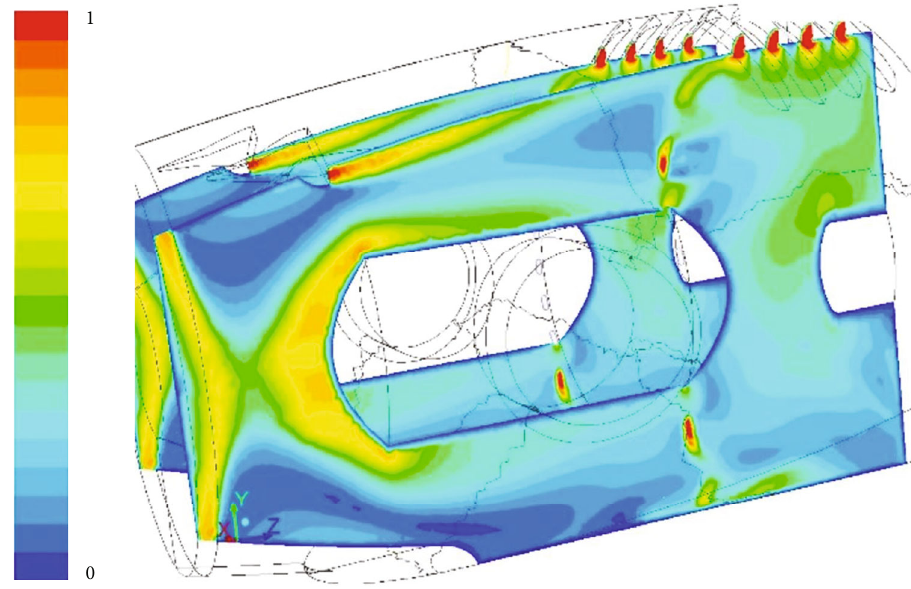
Figure 11: Velocity contours in two parallel vertical planes in the middle of NACA inlet (20 m/s at inlet). Temperature profile relative to peak value